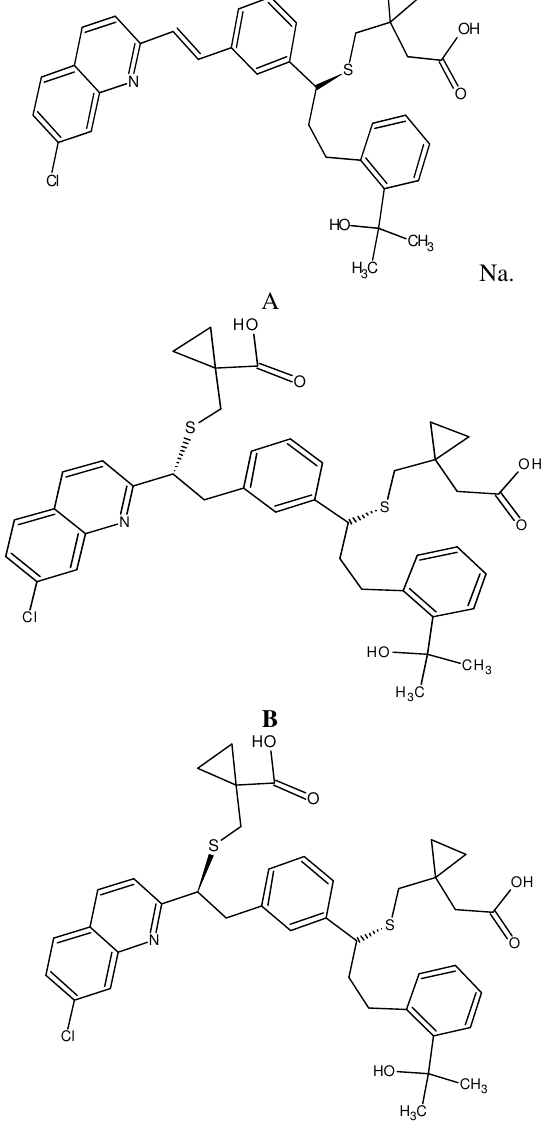
Figure 1. Structure of montelukast sodium compound (A); and impurity Micheal adduct-1(C) and adduct -2